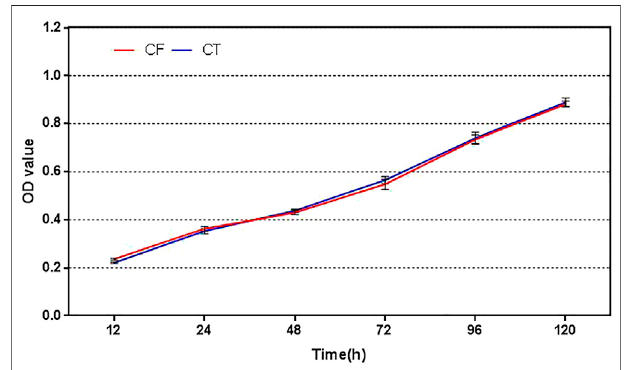
FIGURE 3 | Cell proliferation pro fi les of cells obtained by the without enzyme method and enzyme digestion method. CF: collagenase free, without enzyme, CT: collagenase treated, enzyme digestion, and OD: absorbance.